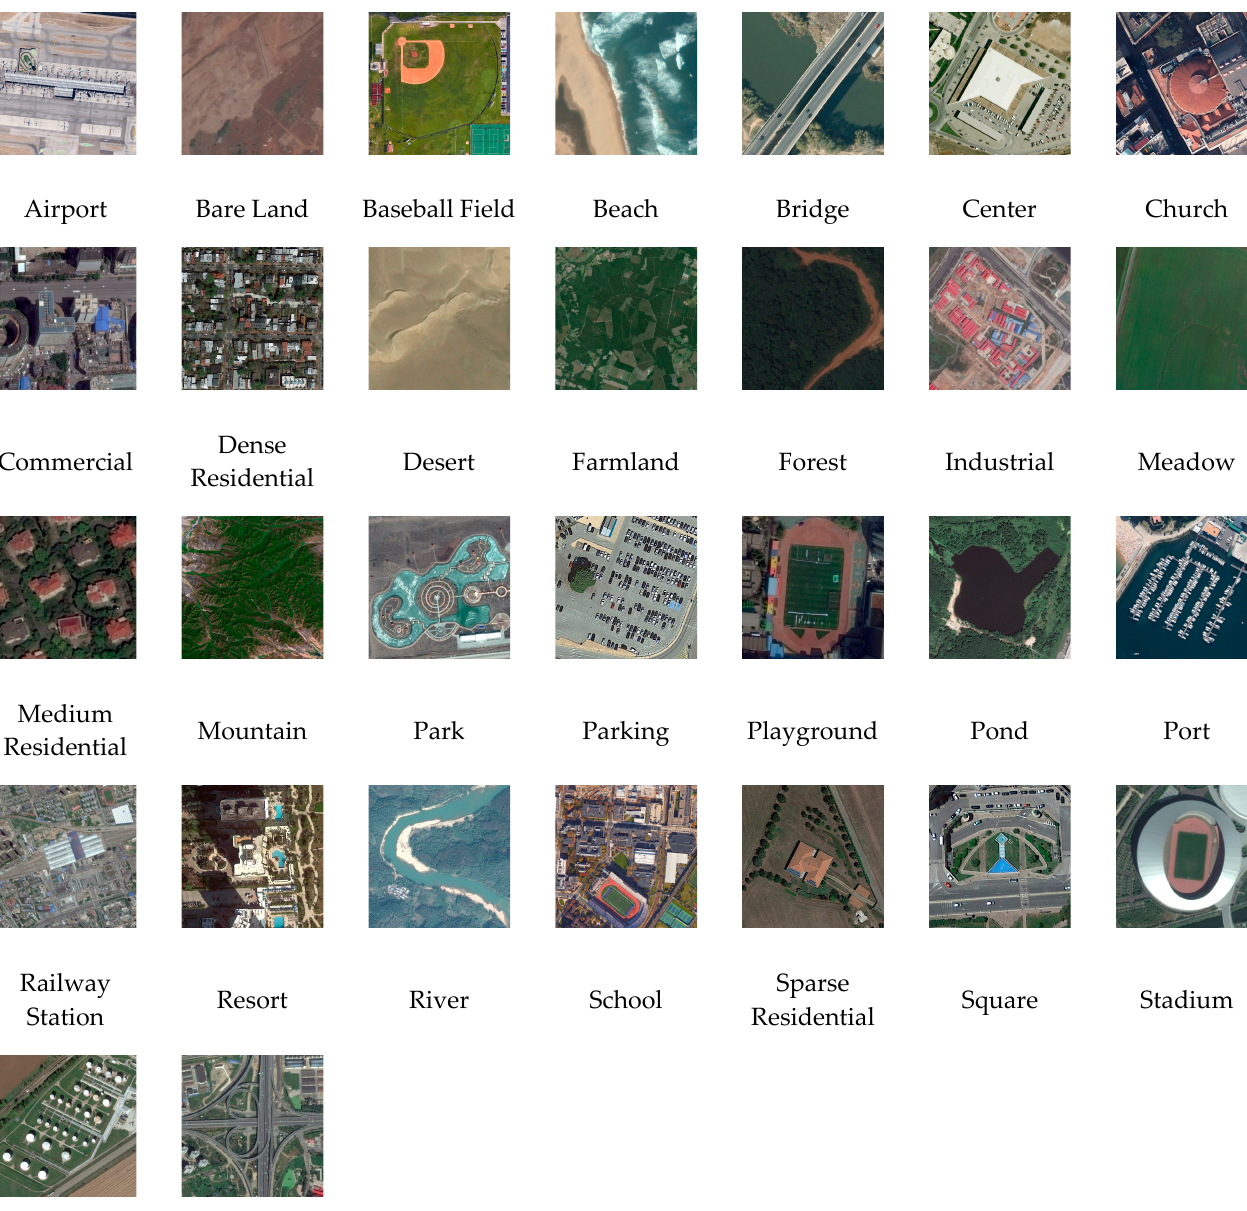
Figure 4. Examples of the AID dataset.